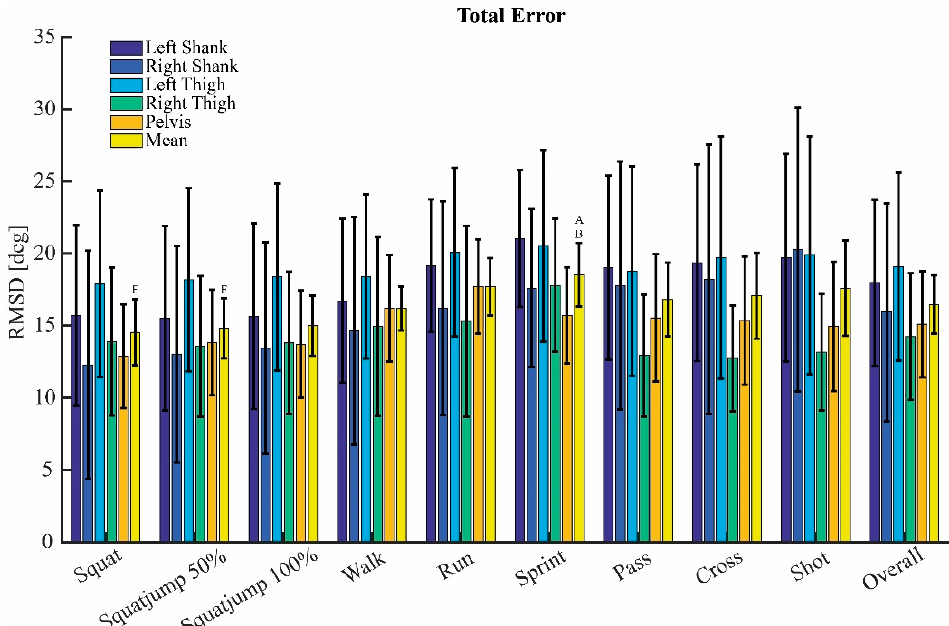
Figure A4. Total error with sensor-body calibration A. Mean root-mean-square differences (RMSD) and standard deviations for all body segments and all trials. Significant differences within each trial between body segments are displayed by letters above the bar, LS, RS, LT, RT, and P mean a significant difference with the left shank, right shank, left thigh, right thigh, and pelvis, respectively. Significant differences between trails are displayed with a letter above the mean bar. A = squat, B = squat jump 50%, C = squat jump 100%, D = walk, E = run, F = sprint, G = pass, H = cross and I = shot.